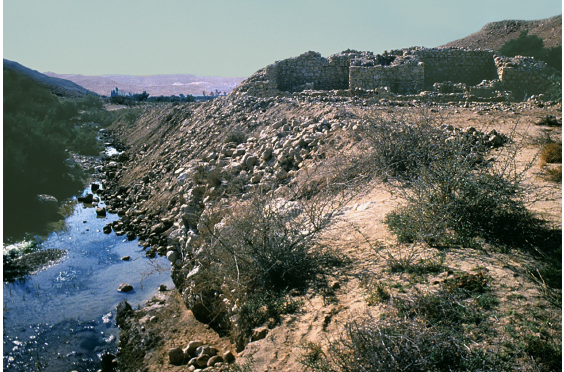
Figure 12 ‘Ein Qudeirat Oasis, identified as Qadesh Barne‘a , with a running stream and the Iron Age